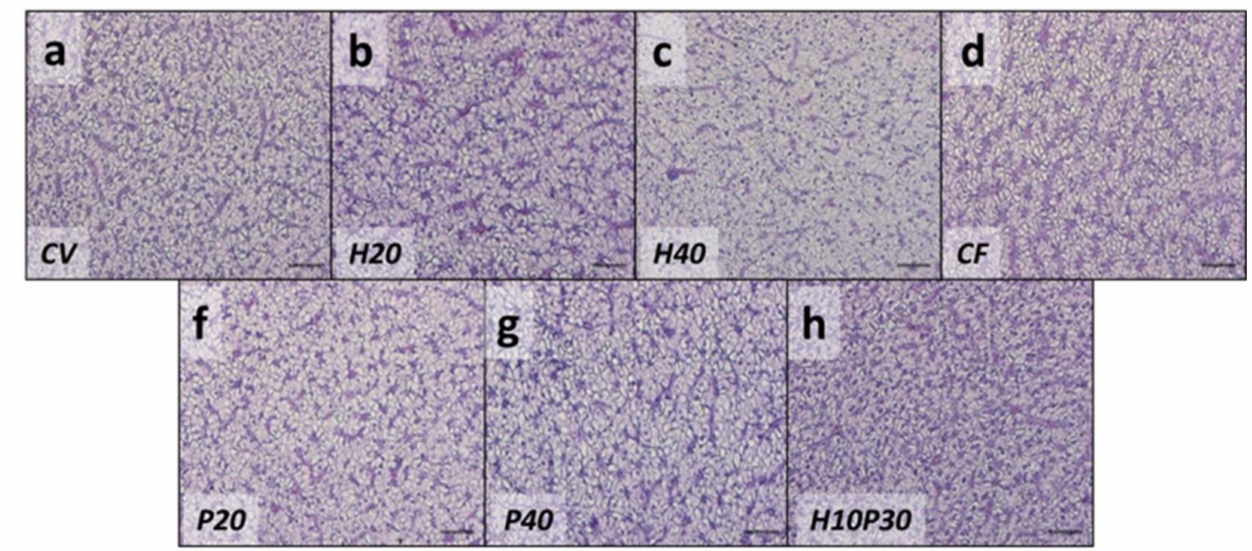
Figure 3. Representative histological images of liver parenchyma from fish fed the experimental diets: ( a ) CV; ( b ) H20; ( c ) H40; ( d ) CF; ( f ) P20; ( g ) P40; ( h ) H10P30. Scale = 100 µ